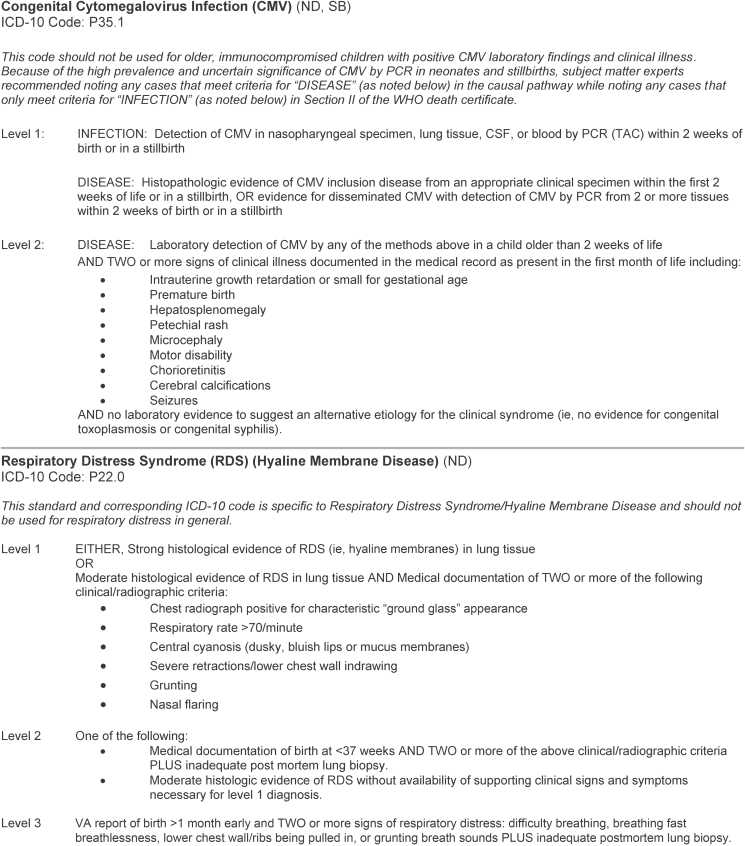
Diagnosis standard examples. The full document can be found https://champshealth.org/protocols/. Neonatal death and stillbirth refer to the type of Child Health and Mortality Prevention Surveillance case for which this standard would be used. Abbreviations: CMV, cytomegalovirus; CSF, cerebrospinal fluid; ICD-10, International Classification of Diseases, Tenth Revision; ND, neonatal death; PCR, polymerase chain reaction; RDS, respiratory distress syndrome; SB, stillbirth; TAC, TaqMan Array Card; VA, verbal autopsy; WHO, World Health Organization.